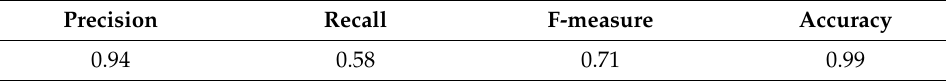
Table 3. Analysis of the picked horizons in Figure